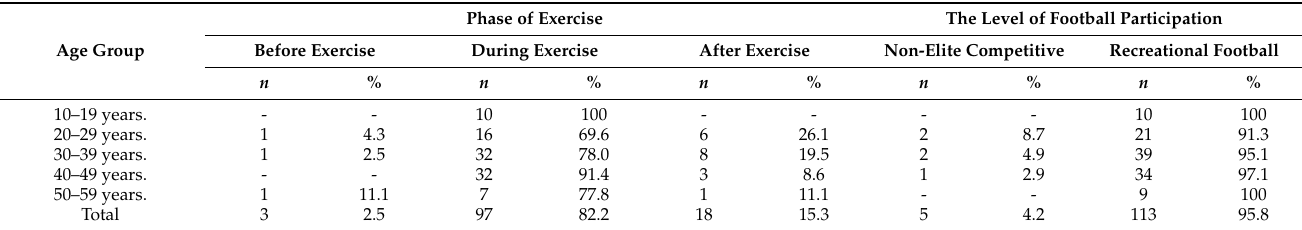
Table 2. The phase of exercise and the level of football participation in which sudden cardiac deaths occur by age groups (2011–2019).